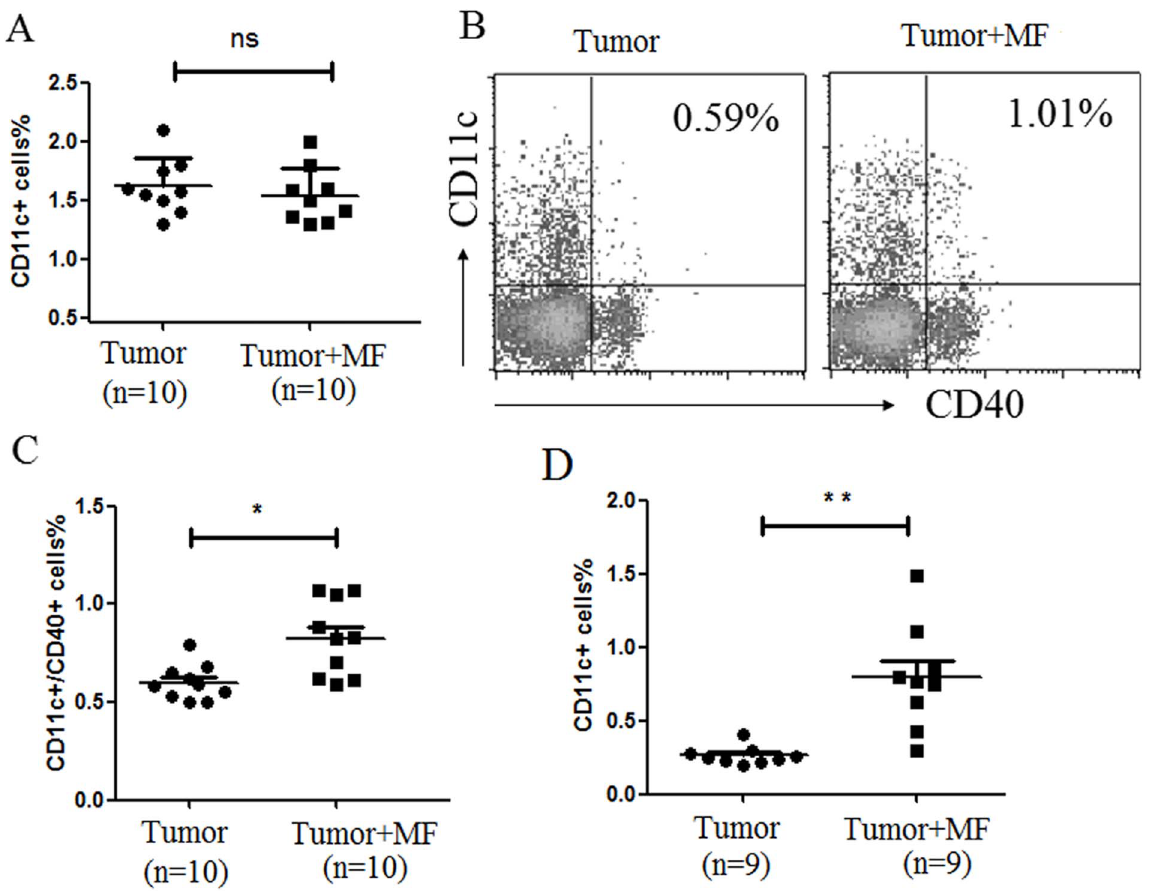
MF could increased percentage of T lymphocytes. In tumor- bearing mice there was an obviously high proportion of CD4 + T and CD8 + T cells after exposure to MF. However, Salerno et al.,